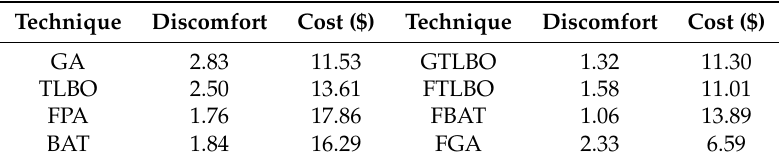
Table 4. Performance